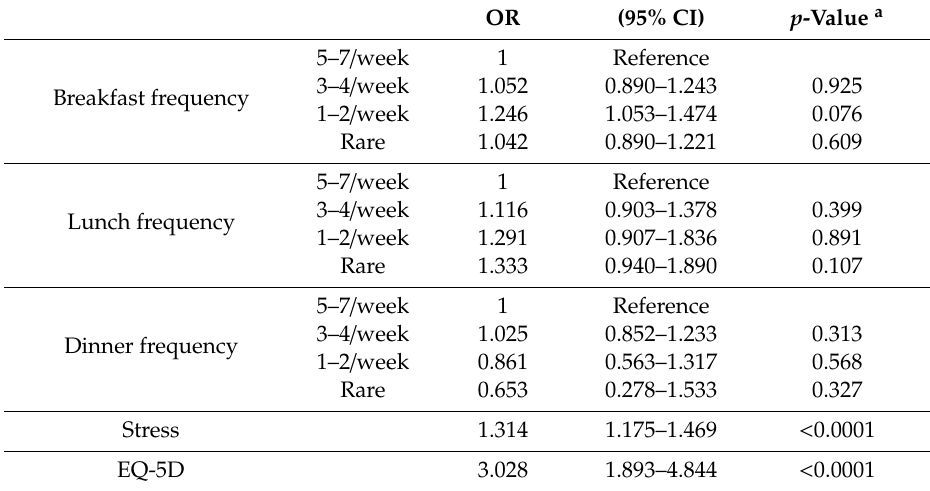
Table 3. Association between NAFLD and dietary habits, stress, and